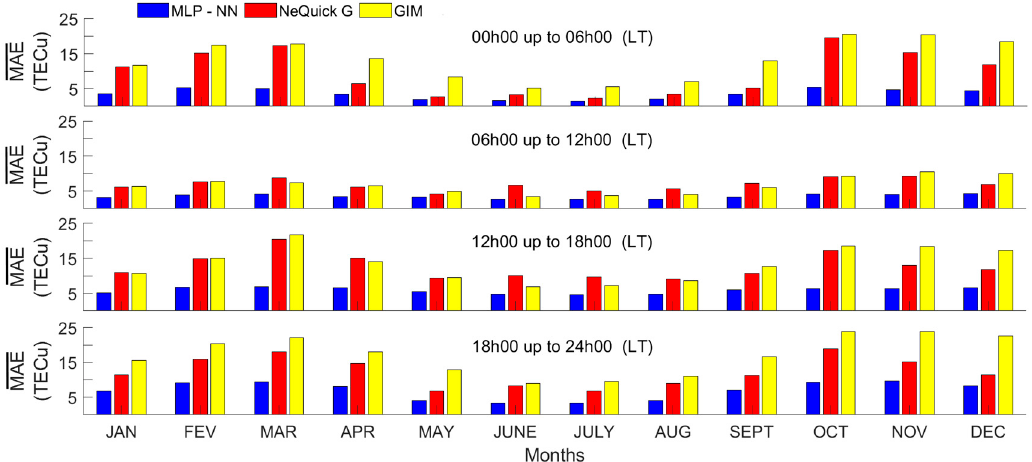
Figure 5. Average MAE (MAE) from the MLP-NN, NeQuick G, and GIM for the year 2014 considering the entire coverage over Brazil. The panels are organized in 4 time intervals to illustrate the seasonal and temporal improvements obtained with the usage of the MLP-NN.